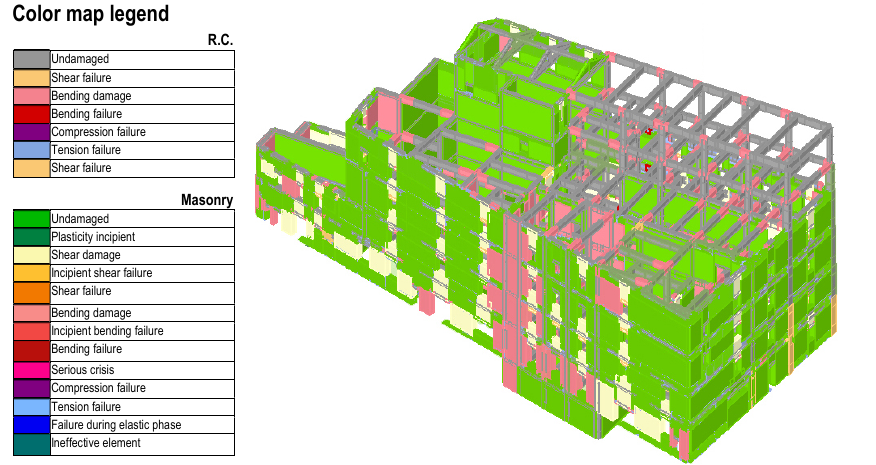
Figure 17. Structural damage at the last step of seismic analysis n.1, direction X (Uniform).